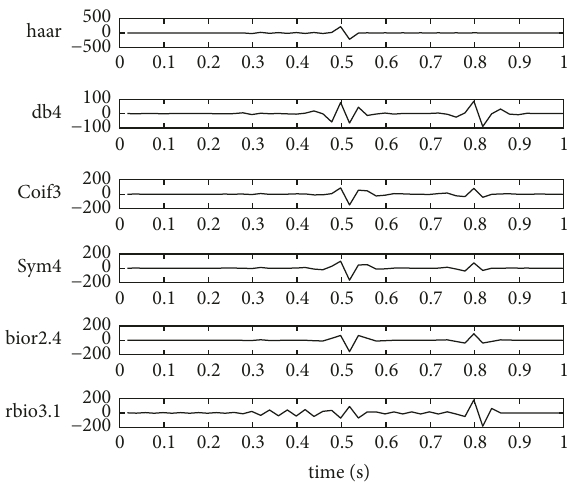
Figure 6: The detail coefficients of the first layer ( haar, db4, Coif3, Sym4, bior2.4, rbio3.1 ).